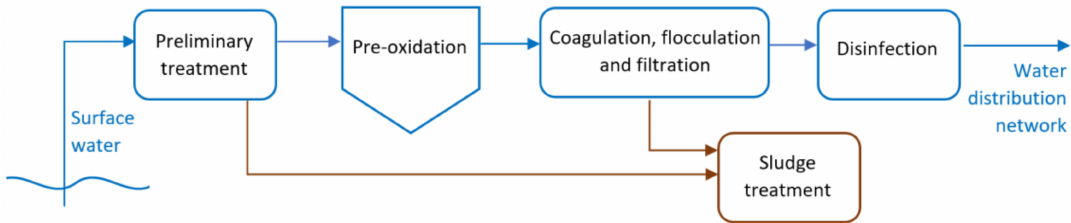
Figure 4. Schematic configuration of Lever